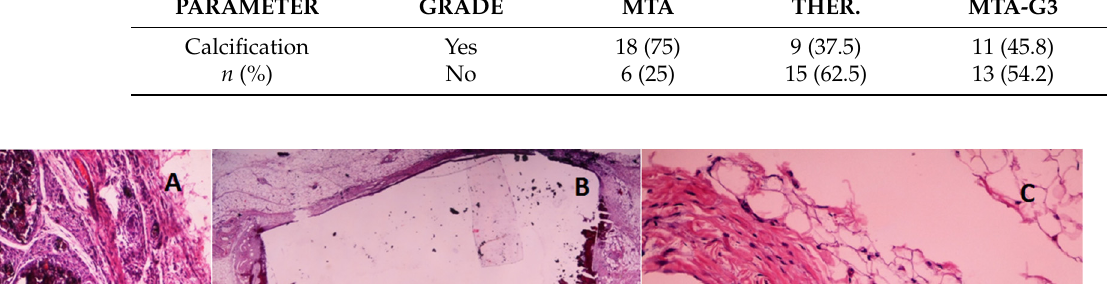
Figure 4. Hematoxylin–eosin stain. ( A ): Dystrophic calcification in the area of contact with MTA 30 days (200×). ( B ): Cal- cification on the open ends of the MTA-G3 polyethylene tube 30 days (40×). ( C ): 136 µm thick fibrous capsule Theracal 45 days (200×). Table 7. Presence of MTA, Theracal and MTA-G3 calcifications.